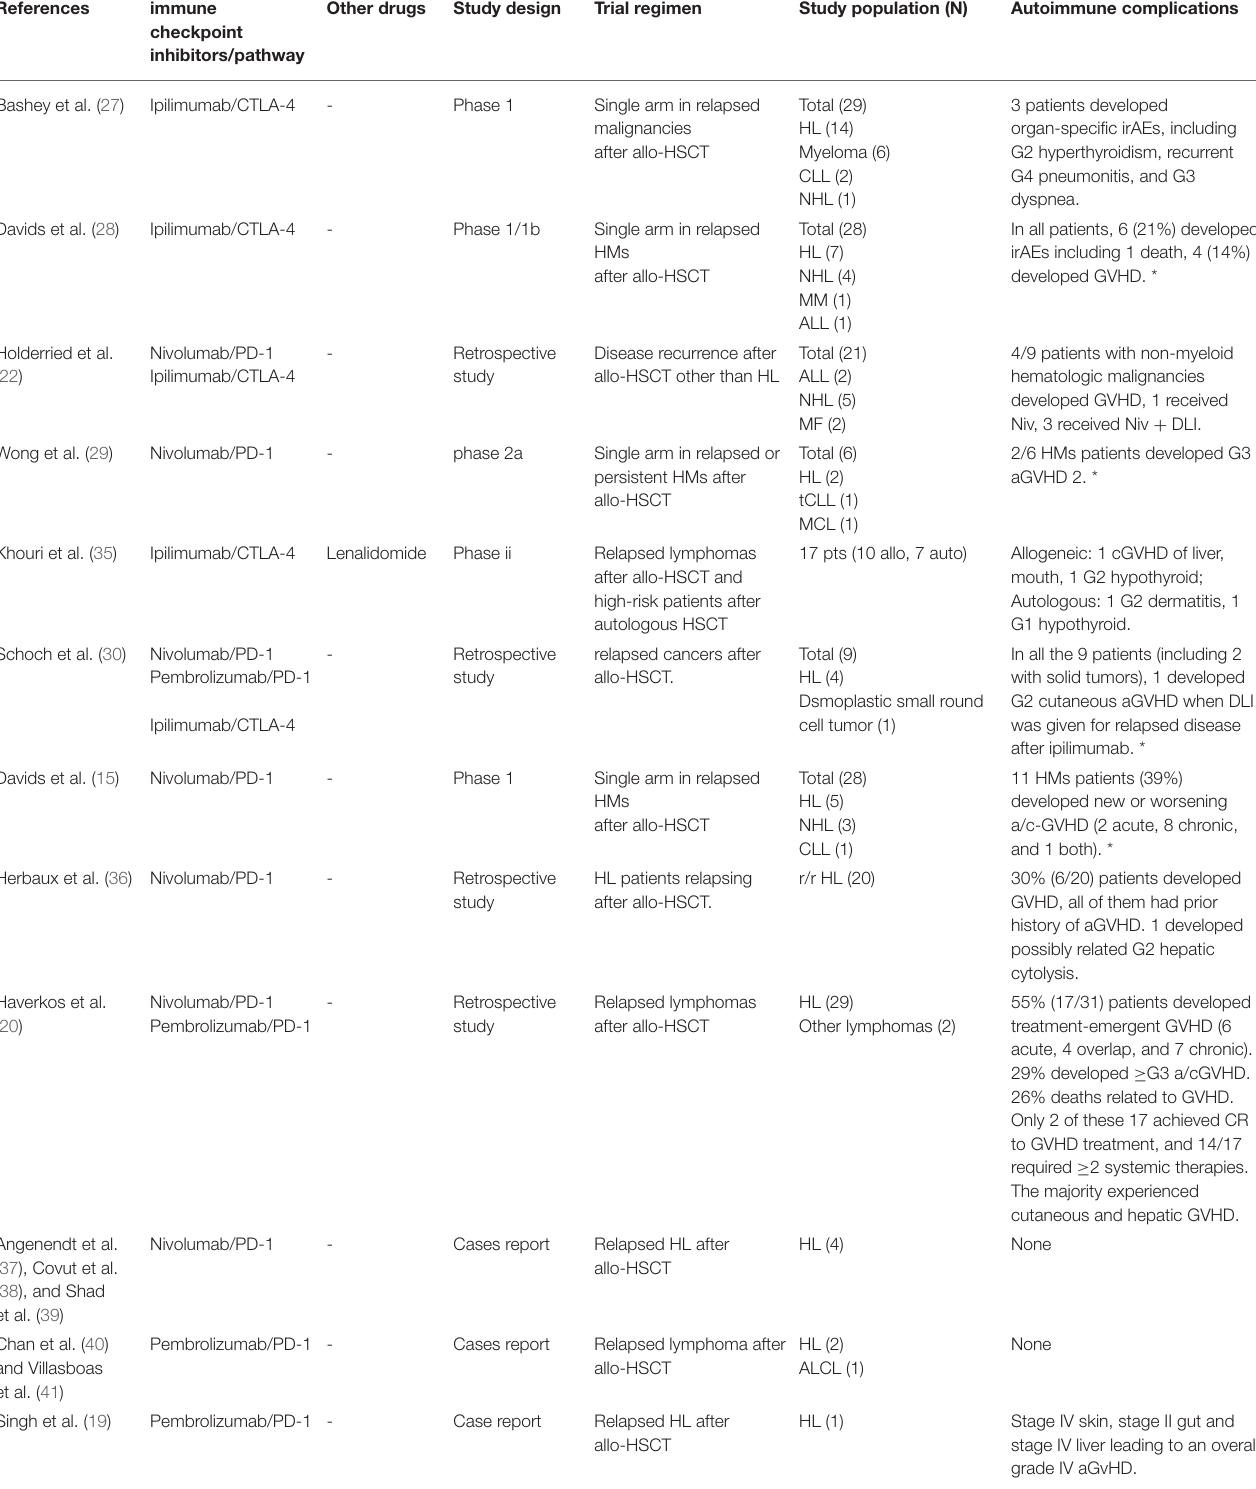
TABLE 2 | Autoimmune complications of the published clinical trials using checkpoint inhibitors in post-allo-HSCT hematologic malignancies other than myeloid